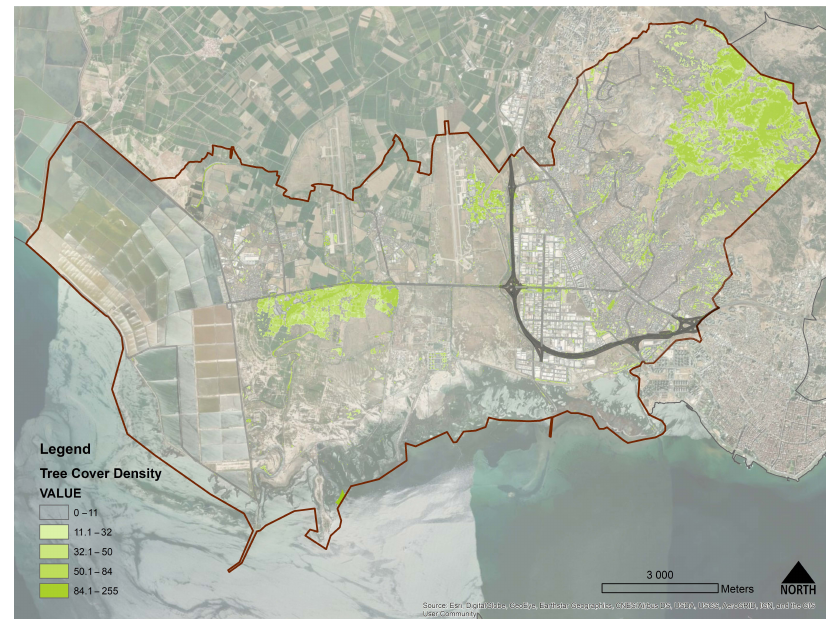
Figure 5. Tree Cover Density Degree on Çi ğ li district (source: author’s